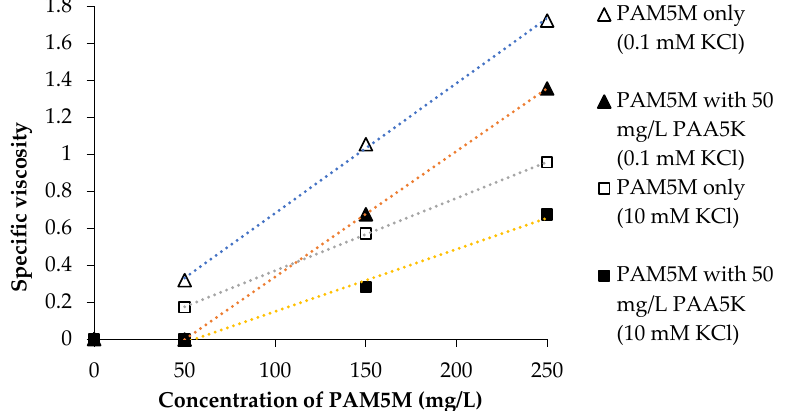
Figure 8. Specific viscosities of PAM5M and PAM5M-PAA5K supernatant solutions as functions of PAM5M concentration at KCl = 0.1 mM and 10 mM